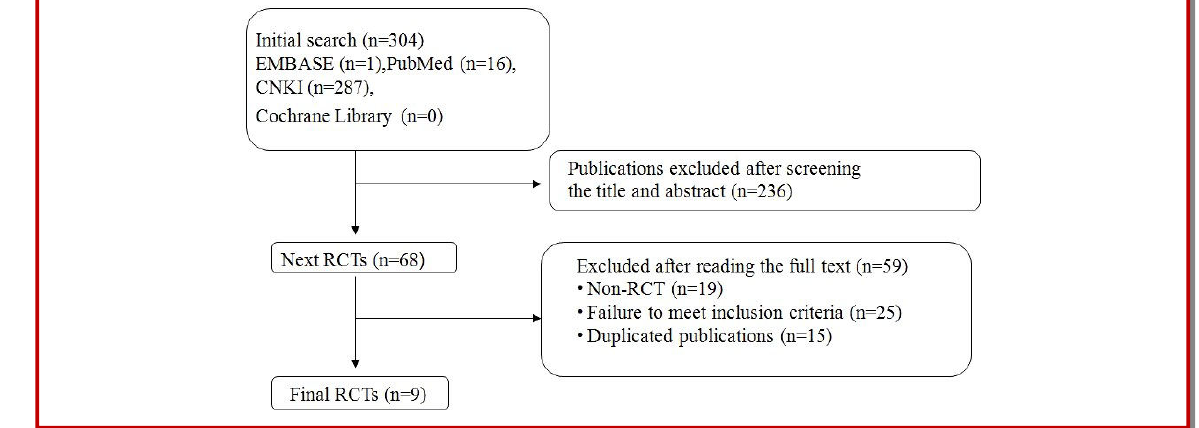
Figure 1: Flowchart of identification of studies included in the